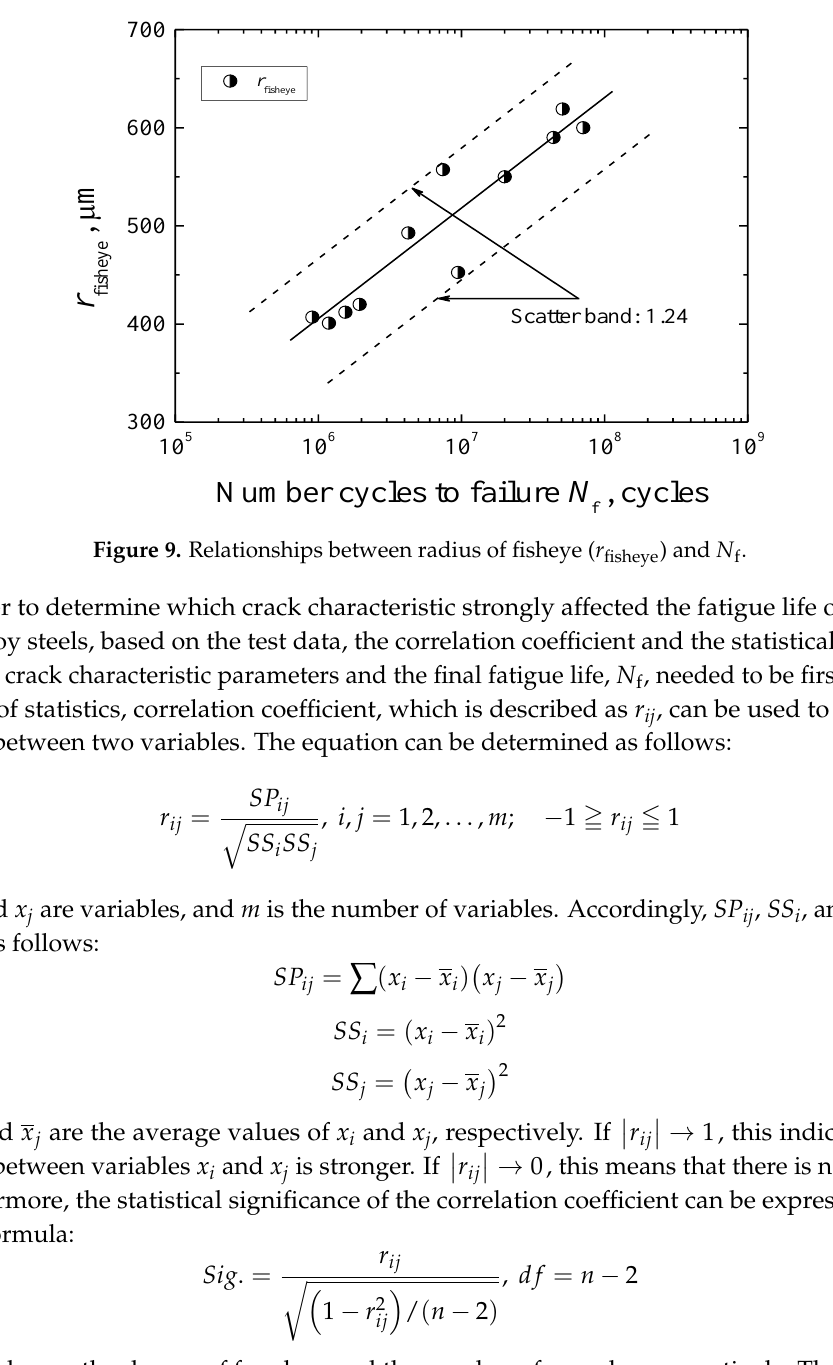
Figure 8. Relationships between radius of inclusion ( r inc ), radius of FGA ( r FGA ), and N f .